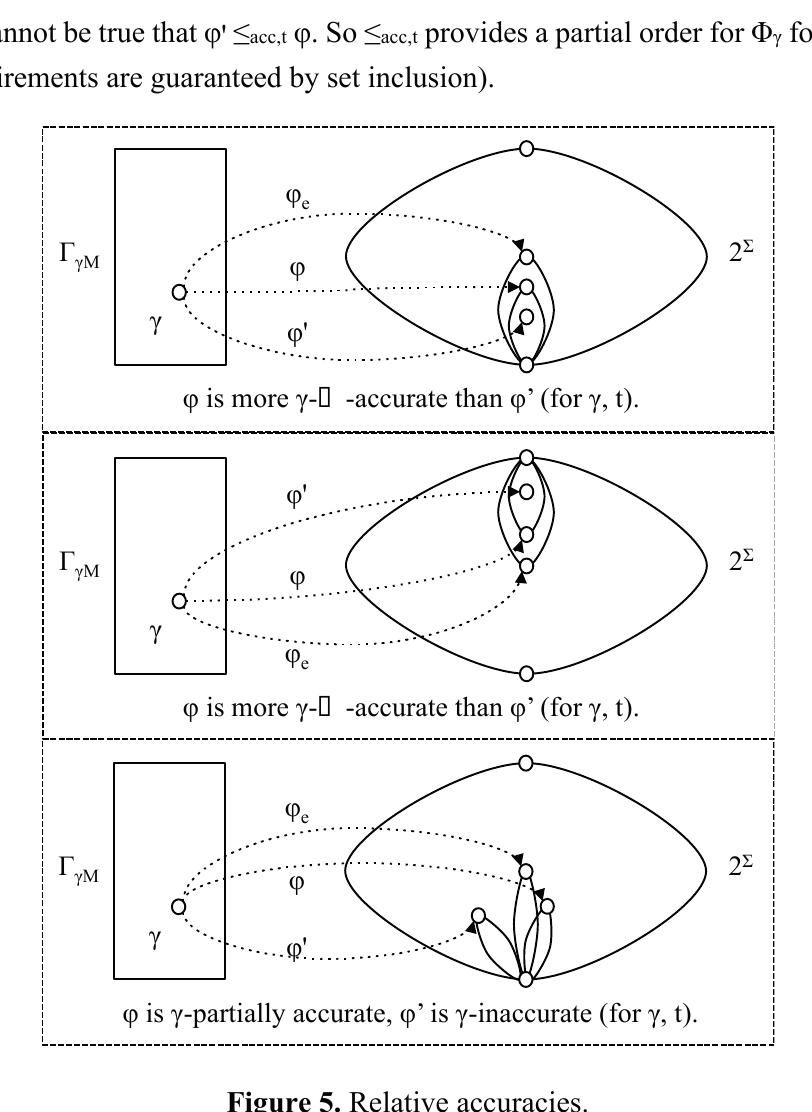
Figure 5. Relative